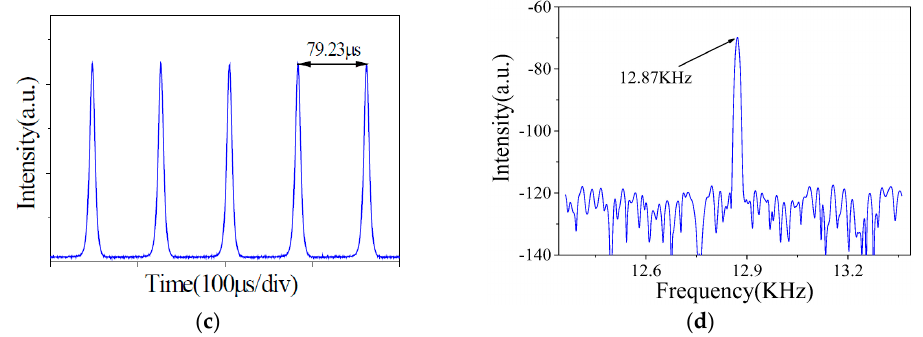
Figure 5. ( a ) Output spectrum; ( b ) pulse profile; ( c ) pulse train; and ( d ) radio-frequency spectrum of the Q-switched fiber laser at the pump of 93.94 mW.